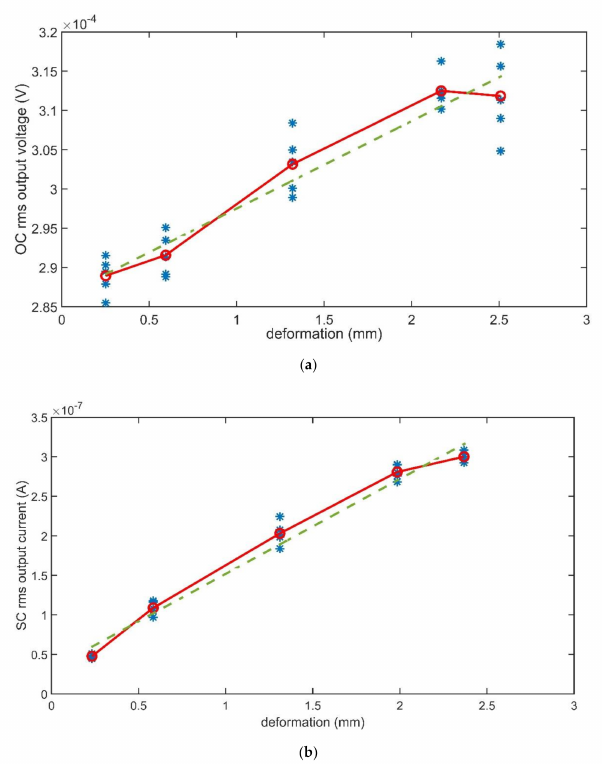
Figure 13. Rms values of the BC-IL-CP OC voltage ( a ) and SC current ( b ) at the composite mechanical resonance frequency (12 Hz), as a function of the